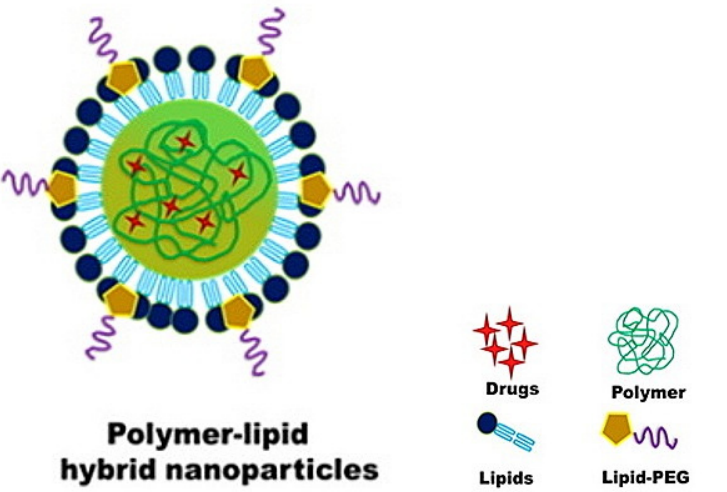
Figure 7. The structure of hybrid lipid–polymer nanoparticles. Adapted from the reference [170].